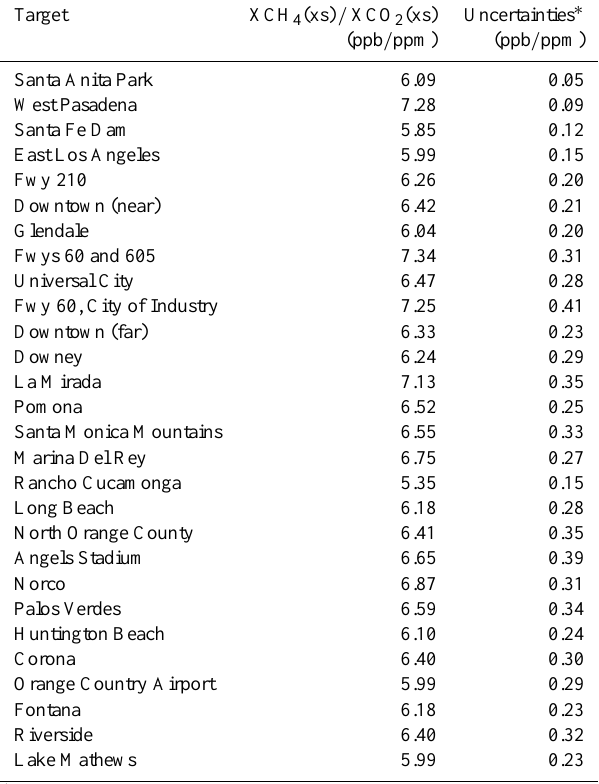
Table 3. List of correlation slopes of XCH 4 ( XS ) :XCO 2 ( XS ) and their uncertainties (1 standard deviation) observed by the CLARS- FTS during the period of September 2011 and October 2013.